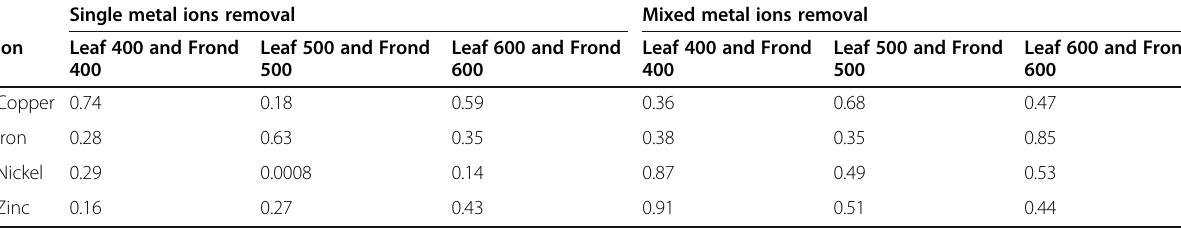
Table 6 T test p values to compare different feedstocks as biochar material Single metal ions